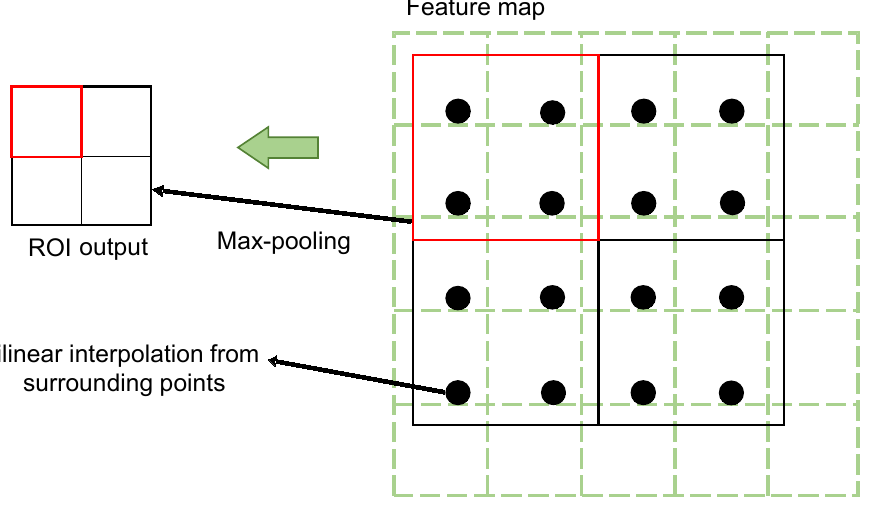
Figure 5. Illustration of ROI Align.